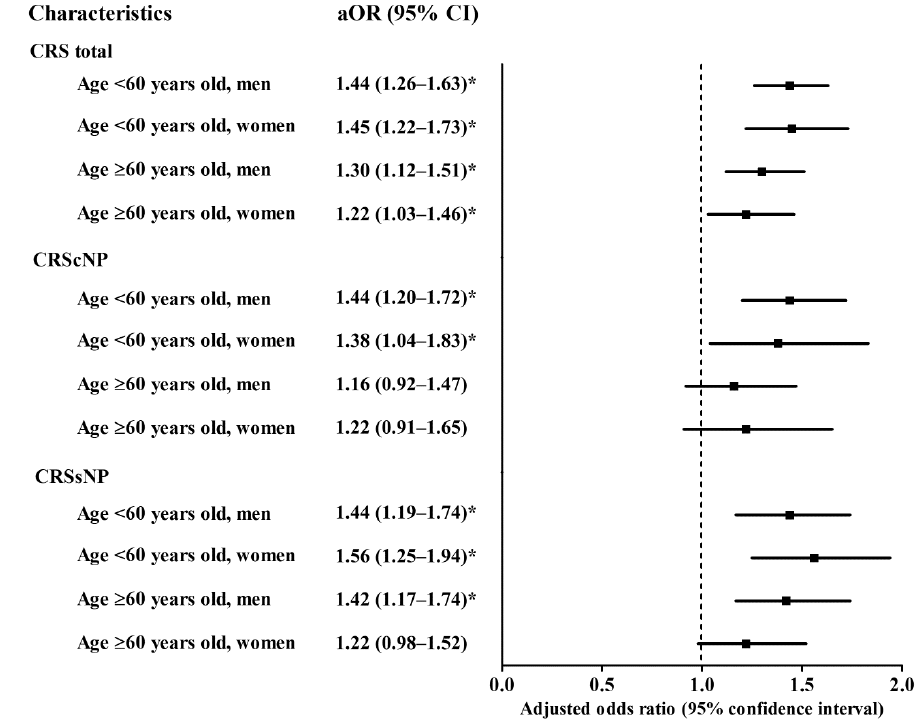
Figure 2. Subgroup analyses by the age and sex. The adjusted odds ratio (aOR) with 95% confidence interval for dyslipidemia in chronic rhinosinusitis (CRS) total/CRS with nasal polyps (CRScNP)/CRS without nasal polyps (CRSsNP) groups compared to each control group. * Significance at p < 0.05.